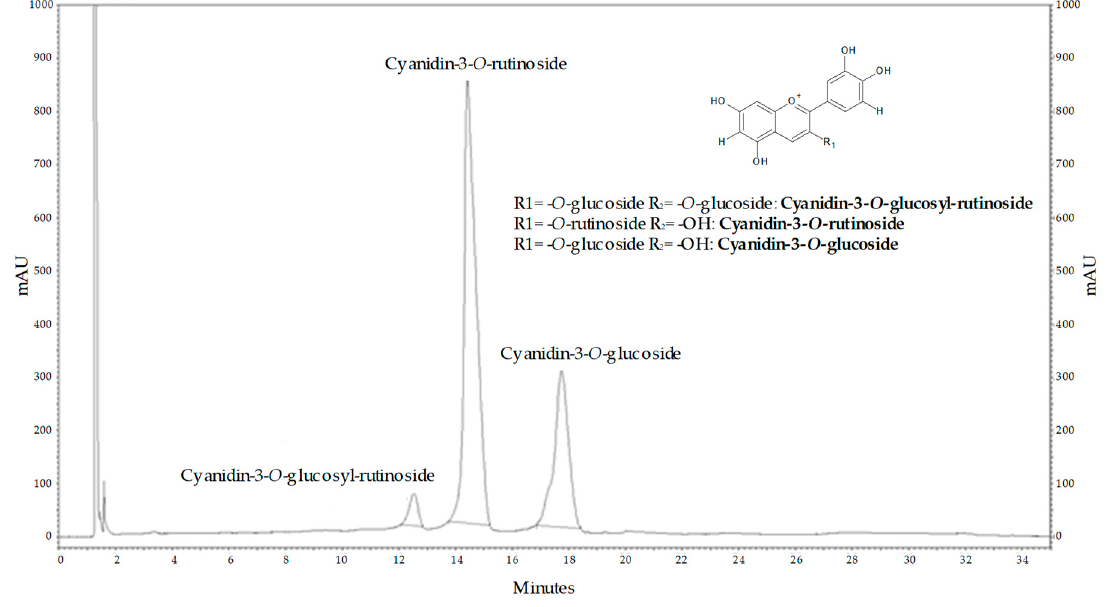
Figure 2. UHPLC chromatogram of sour cherry at 535 nm. Confirmed by standard.